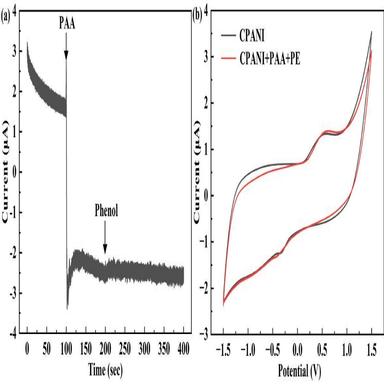
(a) I-t curve, initial voltage = 0.5; (b) CV curve, scan rate = 0.02 V s − 1 . Experimental Conditions: = 0.2 mM, = 20 μM, = 50 mM.